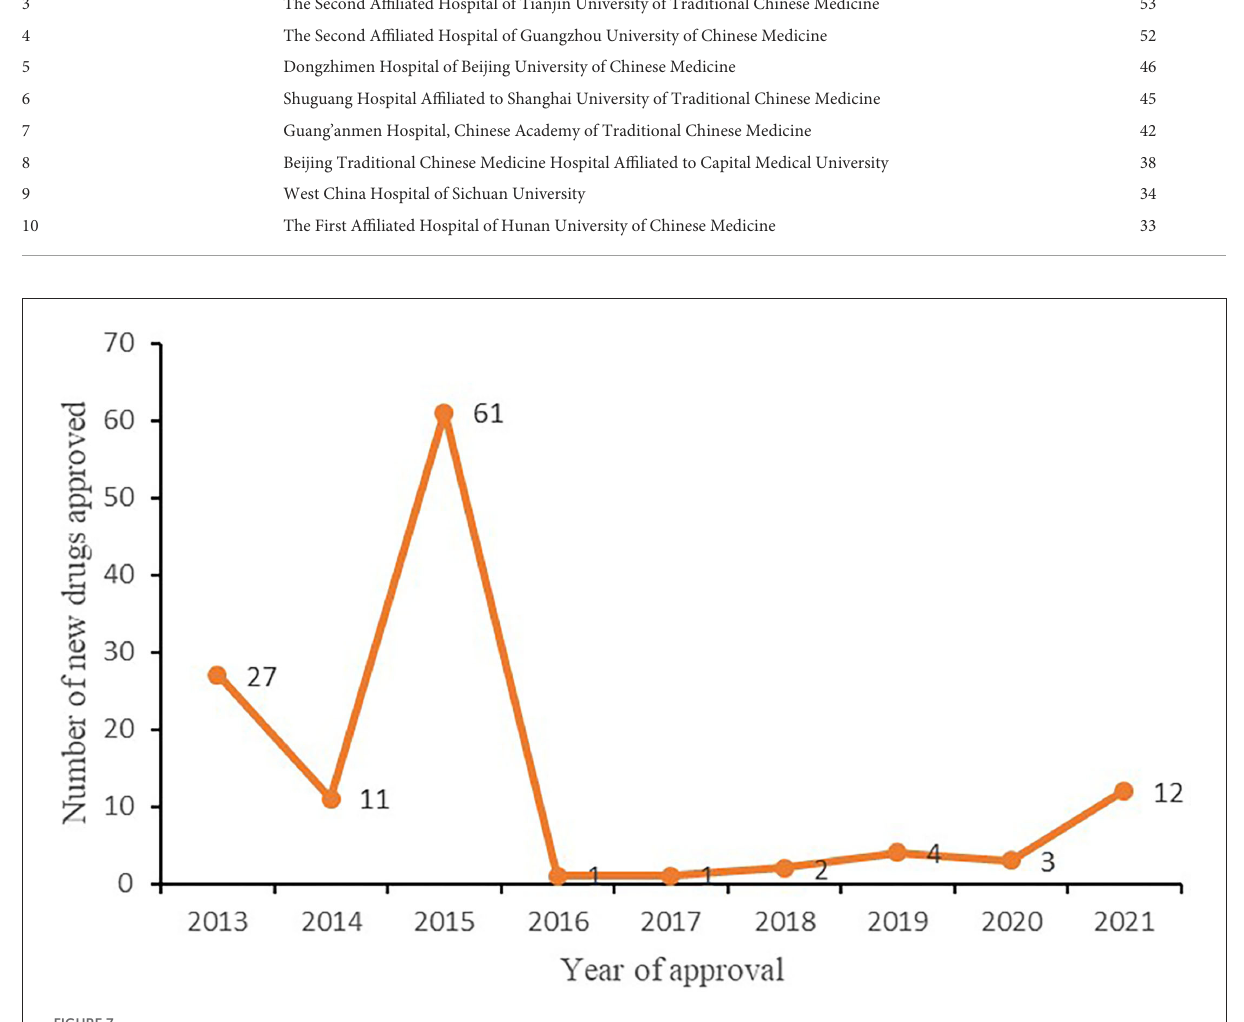
FIGURE7 Number of new TCMs approved in mainland China from 2013 to